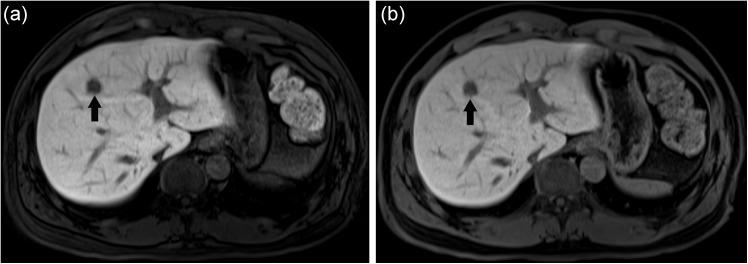
43-year-old male with pathologically proven liver metastasis from rectal cancer.Gadoxetic acid-enhanced T1-weighted MR hepatocyte phase images taken with a 10-minute delay and a 30° flip angle (10min-FA30) (a) and a 20-minute delay and a 10° flip angle (20min-FA10) (b). The liver metastasis in segment 4 showed low signal intensity related to liver parenchyma on both images (dark arrows). The lesion-to-liver CNR of the 10min-FA30 image (190.3) was superior to that of the 20min-FA10 image (137.3). Two different radiologists each gave the 10min-FA30 and 20min-FA10 images a mean subjective score for focal hepatic lesion presence of 4.0.